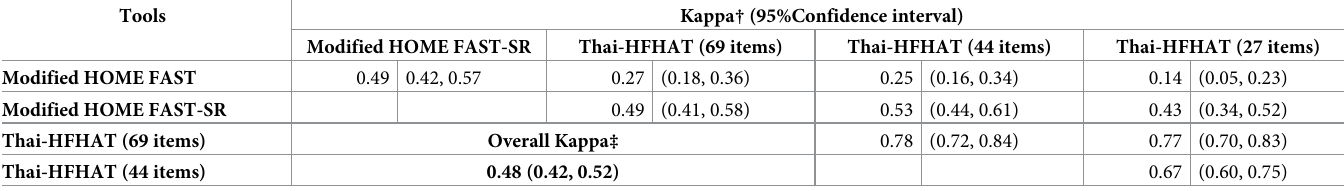
Table 6. Agreement among five home fall hazard assessment tools in classifying subjects into “low” and “high” fall-risk